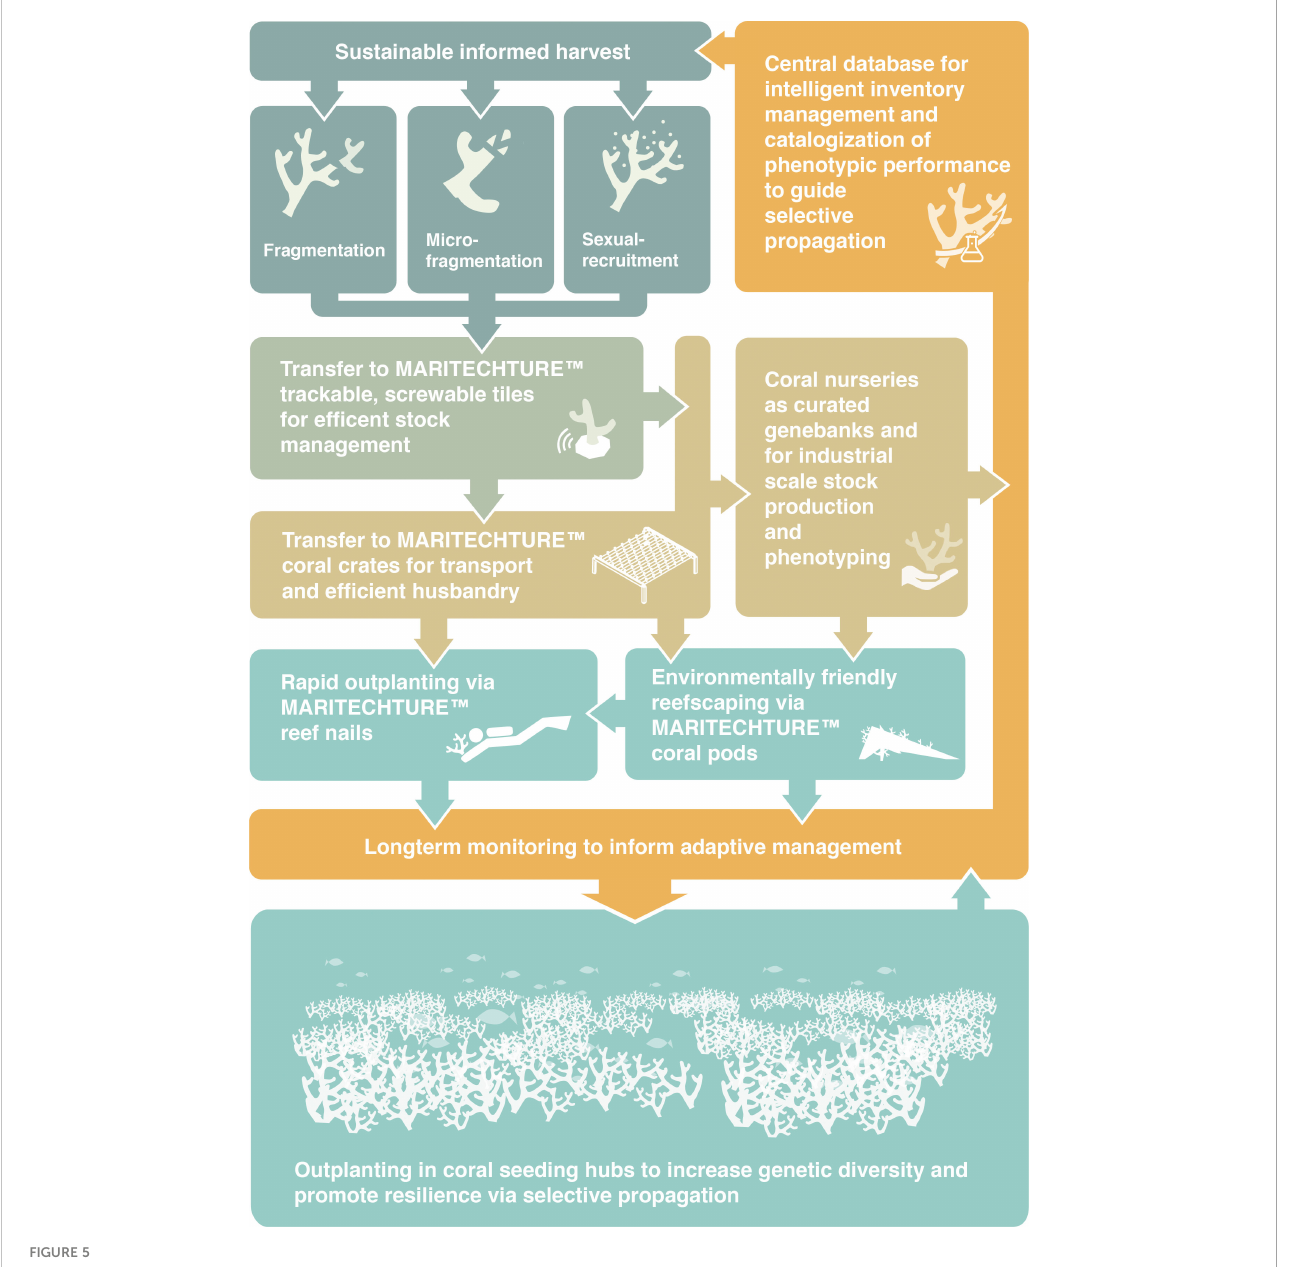
FIGURE 5 Schematic work fl ow illustration of an adaptive management